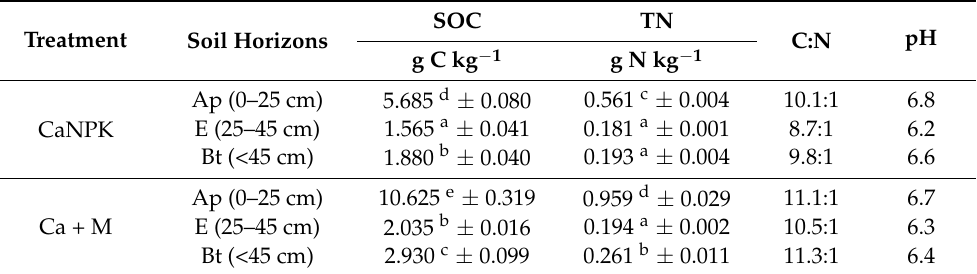
Table 1. The average (1st and 2nd year) content of the soil organic carbon (SOC), total nitrogen (TN) C:N ratio and soil pH.